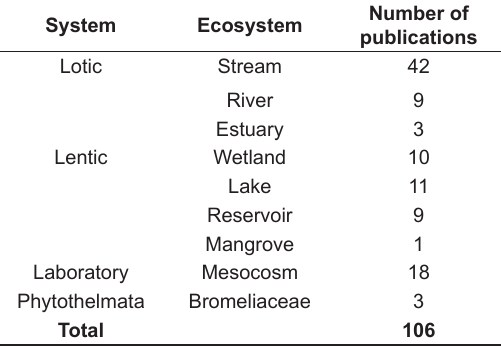
Table 3. Systems and ecosystems where